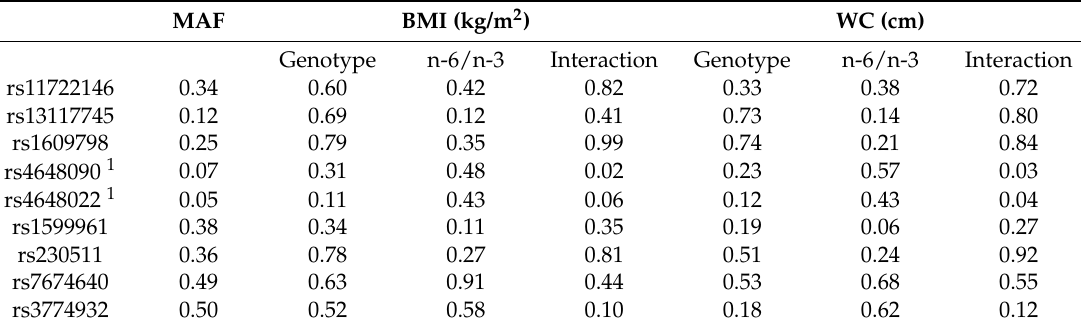
Table 3. Associations ( p values) between the NFKB1 genotypes, circulating lower/higher n-6/n-3 ratio groups, and their interaction on anthropometric traits ( n = 898). MAF BMI (kg/m 2 ) WC (cm) Genotype n-6/n-3 Interaction Genotype n-6/n-3